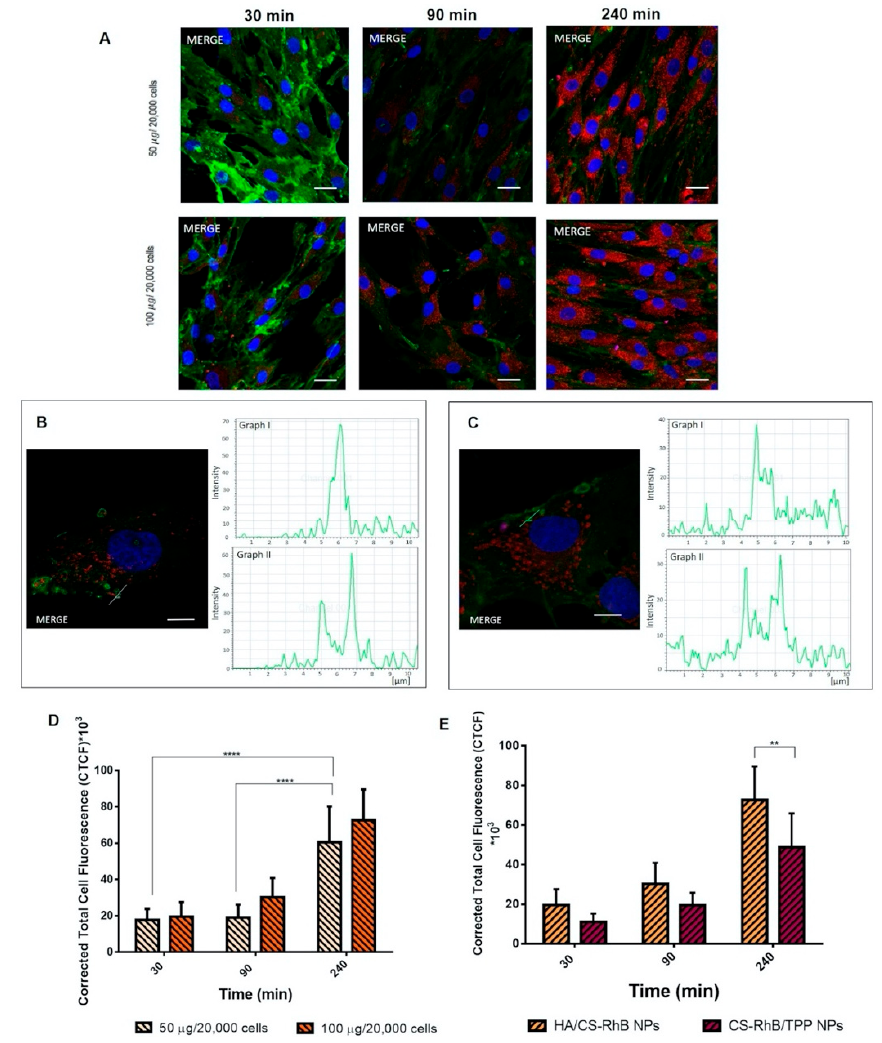
Figure 3. ( A ) Confocal microscopy images of human mesenchymal stem cells (hMSCs) after 30, 90 and 240 min of incubation at 37 ◦ C with di ff erent concentration of HA / CS-RhB NPs (50–100 µ g / 20,000 cells). Red fluorescent denotes HA / CS NPs; nuclear blue fluorescence of DNA with Hoechst33258 dye; positive expression for cluster of di ff erentiation-44 (CD44) on hMSCs membrane was detected by using anti-CD44 primary antibody and FITC labeled secondary antibody (green fluorescence), scale bar = 20 µ m. ( B ) Detail of the endocytic vesicles formation: confocal image of hMSCs after 90 min incubation with HA / CS-RhB NPs (50 µ g / 20,000 hMSCs), a yellow line, crossing a vesicle, was drawn and the analysis of the red and green fluorescence intensities across this line was reported in graph I and II, respectively (scale bar = 10 µ m). ( C ) Detail of the endocytic vesicles formation: confocal image of hMSCs after 90 min incubation with HA / CS-RhB NPs (100 µ g / 20,000 hMSCs), a yellow line, crossing a vesicle, was drawn and the analysis of the red and green fluorescence intensities across this line was reported in graph I and II, respectively (scale bar = 10 µ m). ( D ) E ff ect of treatment time on red fluorescent intensity of the internalized HA / CS-RhB NPs (50–100 µ g / 20,000 cells). Results are presented as mean ± SD.**** p < 0.001. ( E ) Red fluorescent intensities of HA / CS-RhB NPs and CS-RhB / TPP NPs (100 µ g / 20,000 hMSCs) localized in the cell cytoplasm after 30, 90, 240 min of incubation. Results are presented as mean ± SD. ** p value <